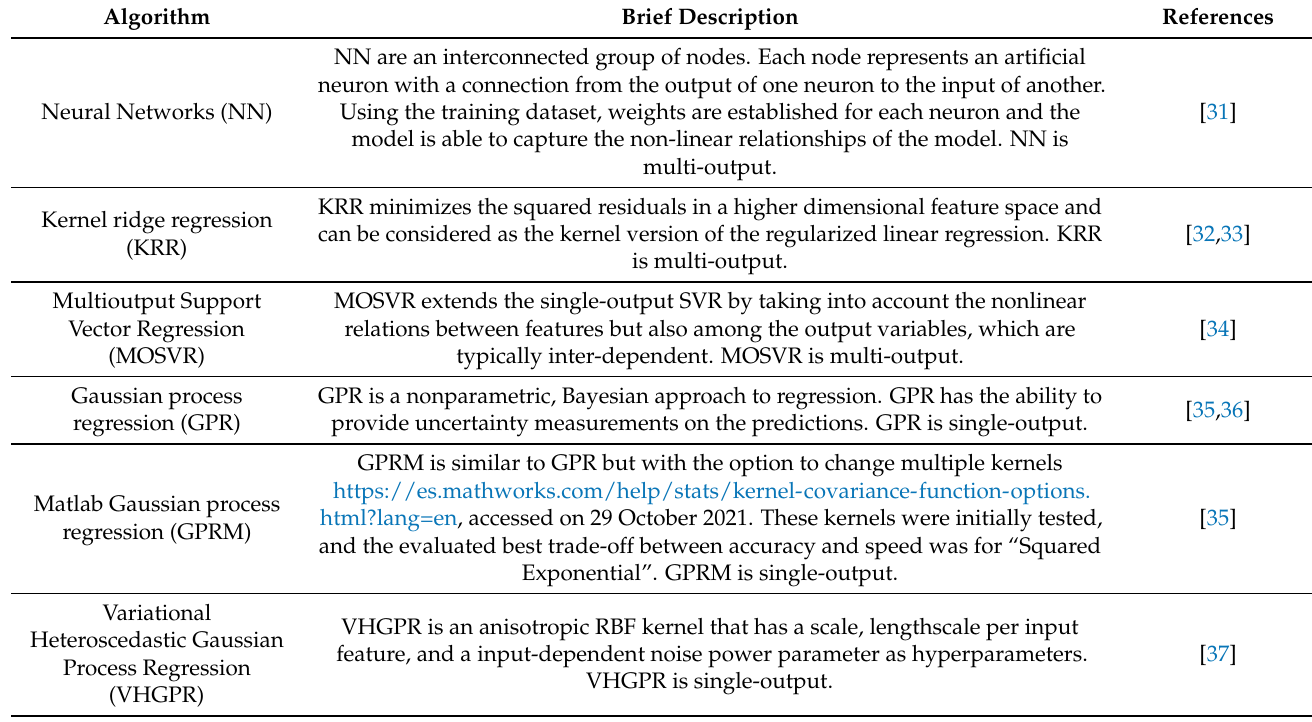
Table 1. List of selected MLRAs used for emulation implemented in ARTMO toolbox.